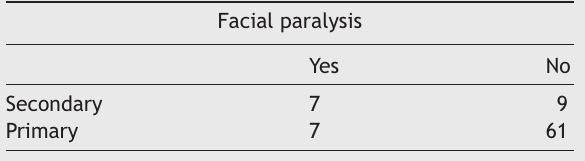
Case-control table --- primary versus secondary surgery.